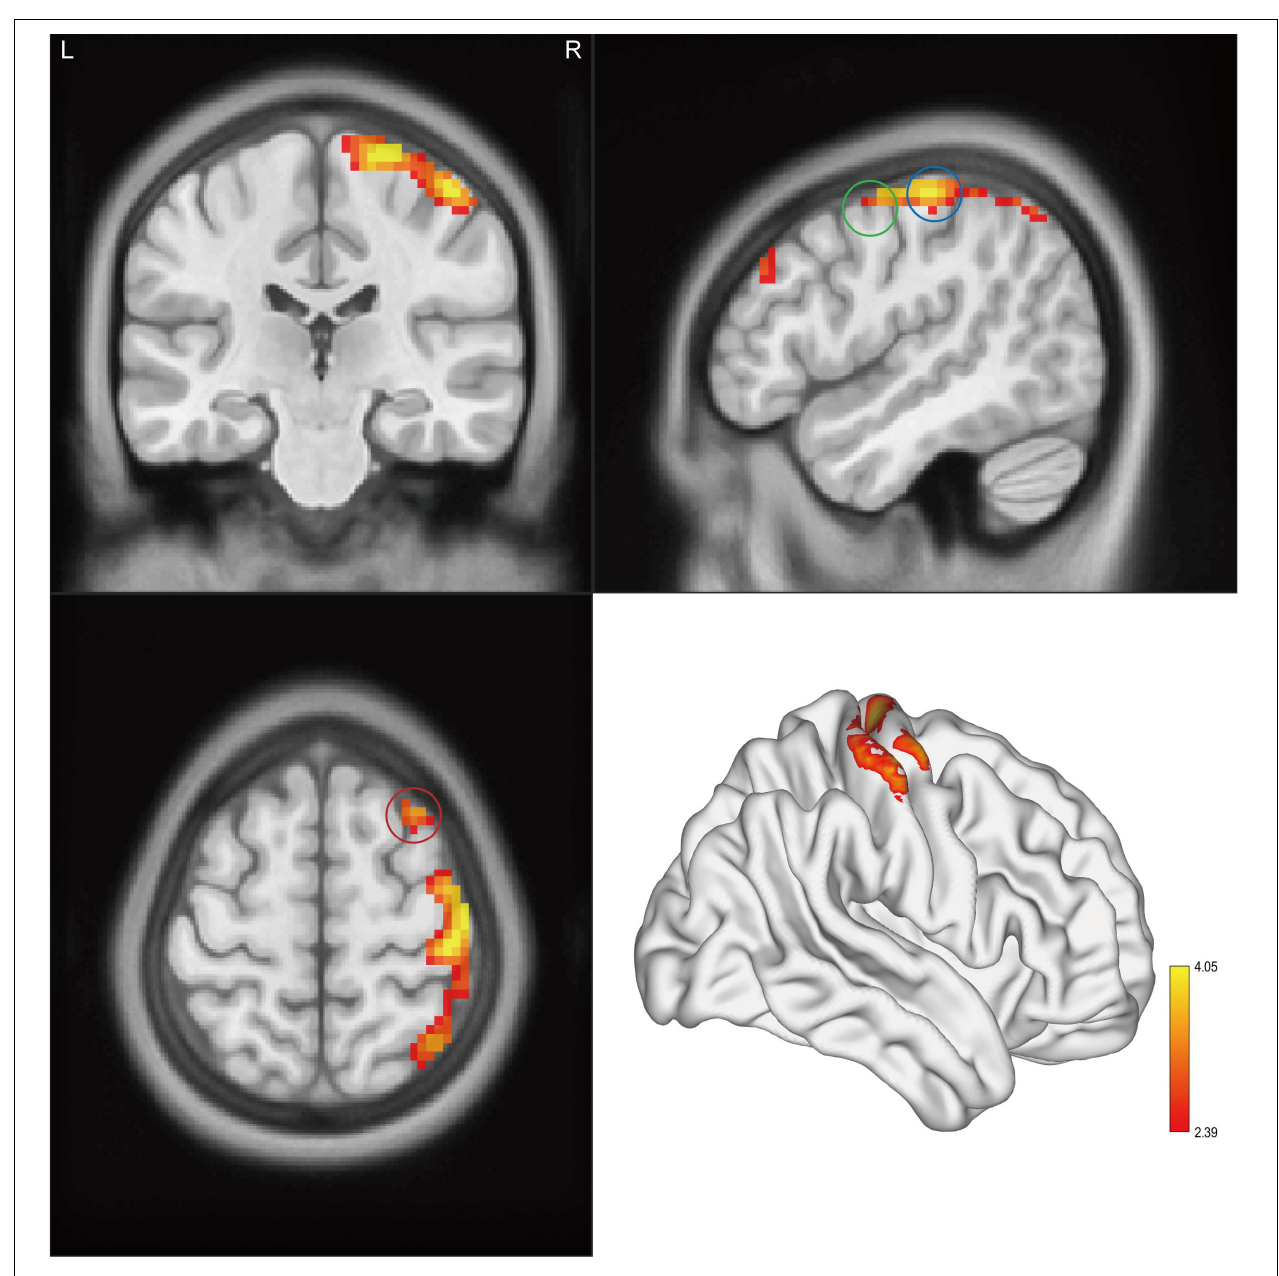
FIGURE 1 | Clusters showed a significant difference in ALFF between CAI patients and HCs. The color bar indicated the t -value from two-sample t -test. The circles indicated the corresponding brain regions. The green circle: the right precentral gyrus; the blue circle: the right postcentral gyrus; and the red circle: the right middle frontal